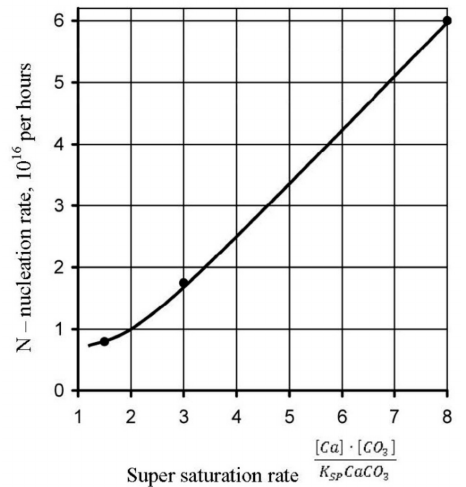
Figure 16. Dependence of nucleation rate N (number of nuclei formed per second) on calcium carbonate supersaturation